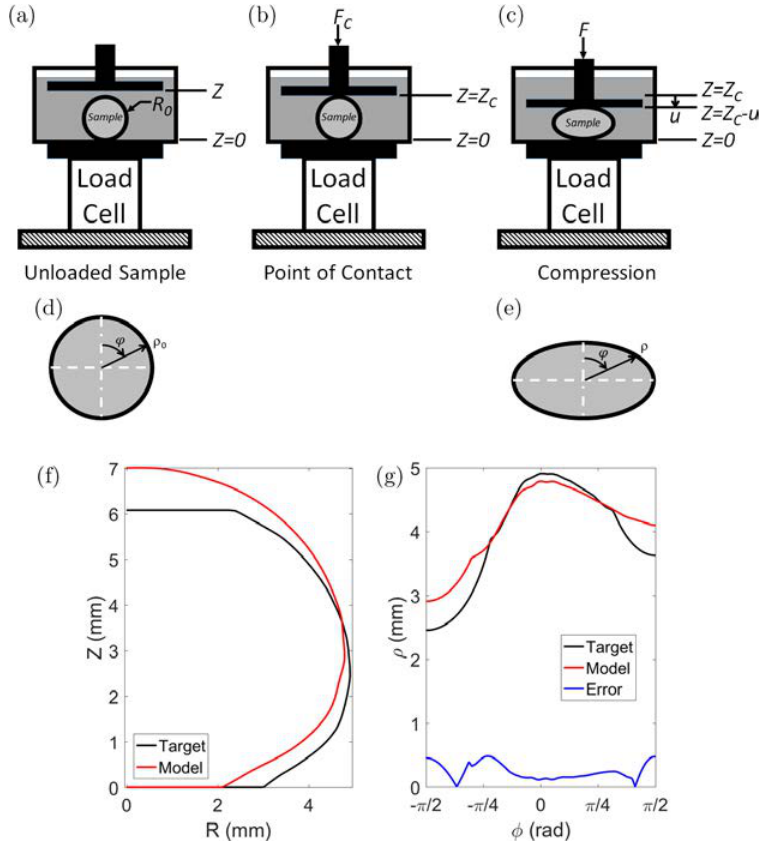
Fig. 4. Above: Schematic of the lens compression test. (a) Prior to contact, the zero gap is established and the lens photographed, (b) then, contact is established, setting the initial force and position, and (c) the lens is compressed by a load F to an extent (cid:2) . The lens' cross-sectional pro¯le is determined for (d) the initial geometry (de¯ned as (cid:5) 0 ( ’ )) and (e) the loaded geometry ( (cid:5) ( ’ )). Below: Example of the comparison for a decapsulated porcine lens in Cartesian ( f ) and polar ( g )